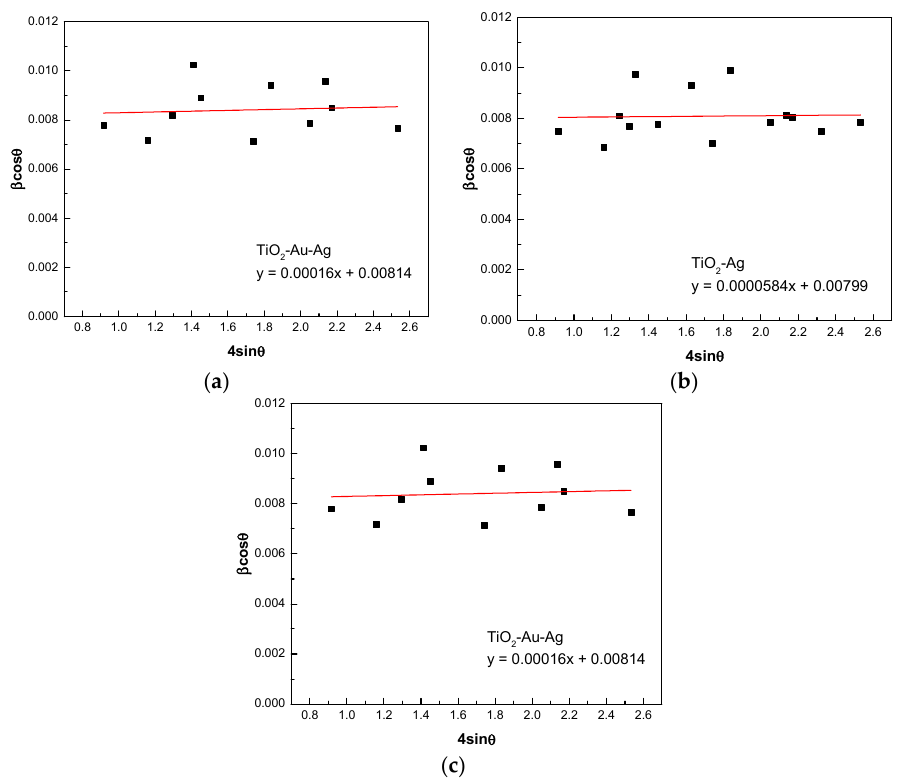
Figure 3. W–H analysis of TiO 2 metal-modified thin films ( a ) Au, ( b ) Ag, and ( c ) Au-Ag. Figure 4 shows the Raman spectra obtained for the different samples. In all cases vibrational features at 143.3 cm − 1 (E g ), 196.3 cm − 1 (E g ), 397.1 cm − 1 (B 1g ), 517.4 cm − 1 (A 1g + B 1g ), and 638.6 cm − 1 (E g ), characteristic of the TiO 2 anatase crystalline, were observed. No vibrational modes due to the rutile phase were detected [40,41].